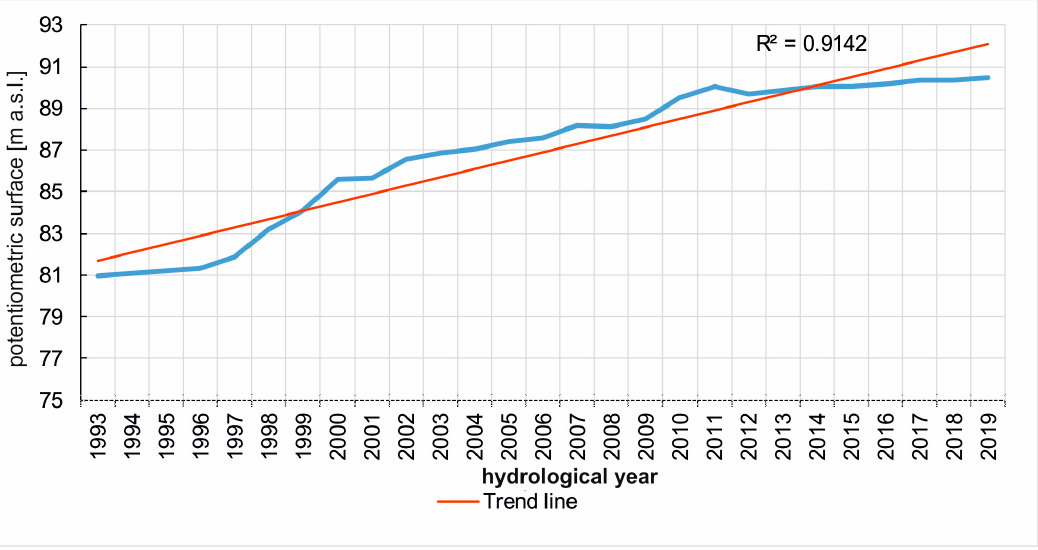
Figure 6. Monthly average potentiometric surface of Oligocene aquifer.